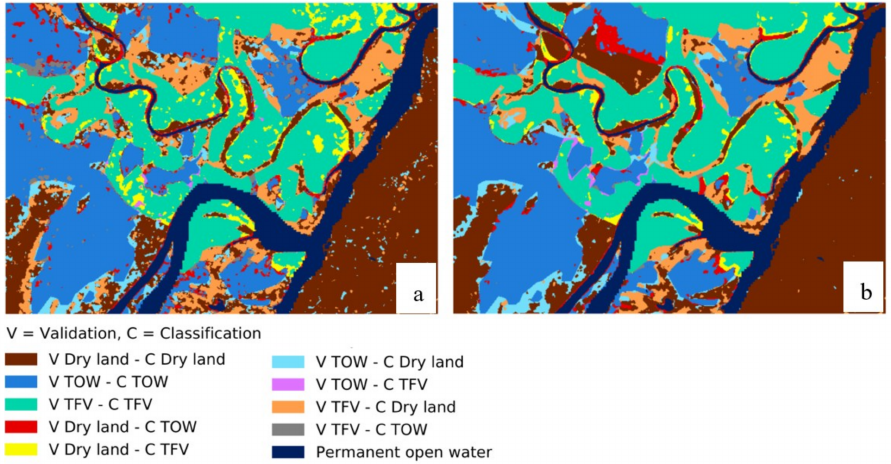
Figure 10. Areas of correspondence and misclassifications for the classes TOW, TFV, and Dry Land using pixel-based ( a ) and object-based ( b ) classification, which are generated by the intersection of the classifications and the validation data.